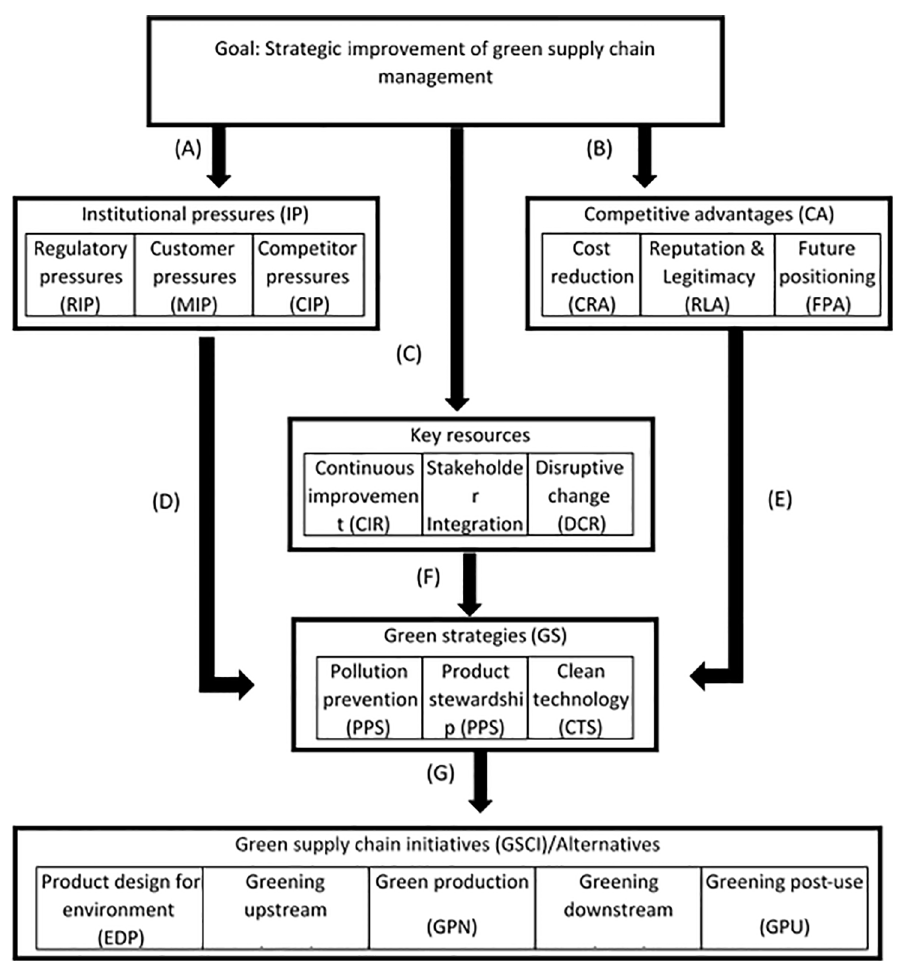
Fig 3. Decision model for improvement of strategic green supply chain